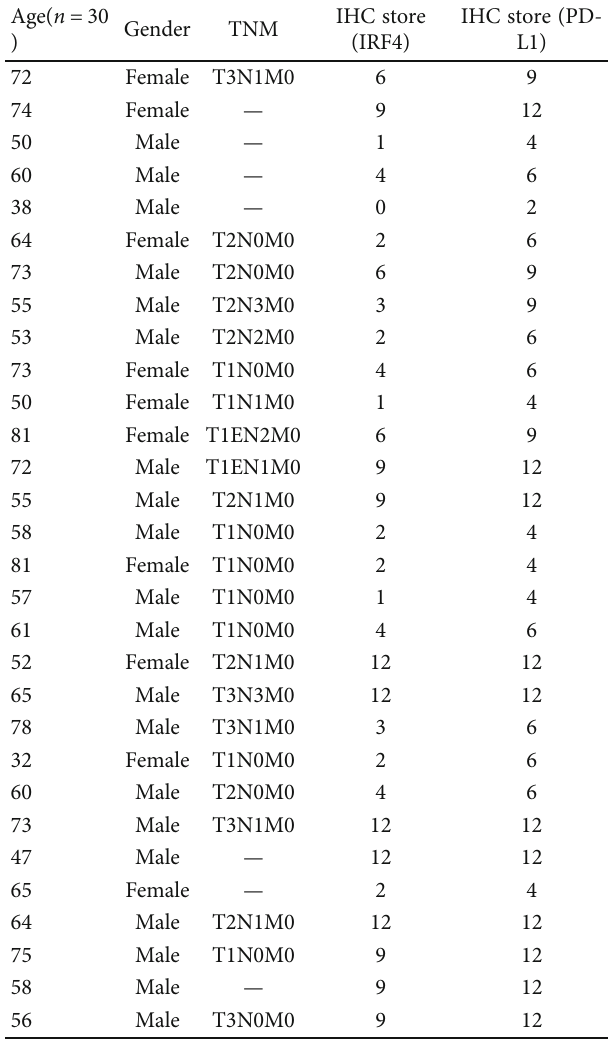
Table 2: Detailed information of tissue array used in